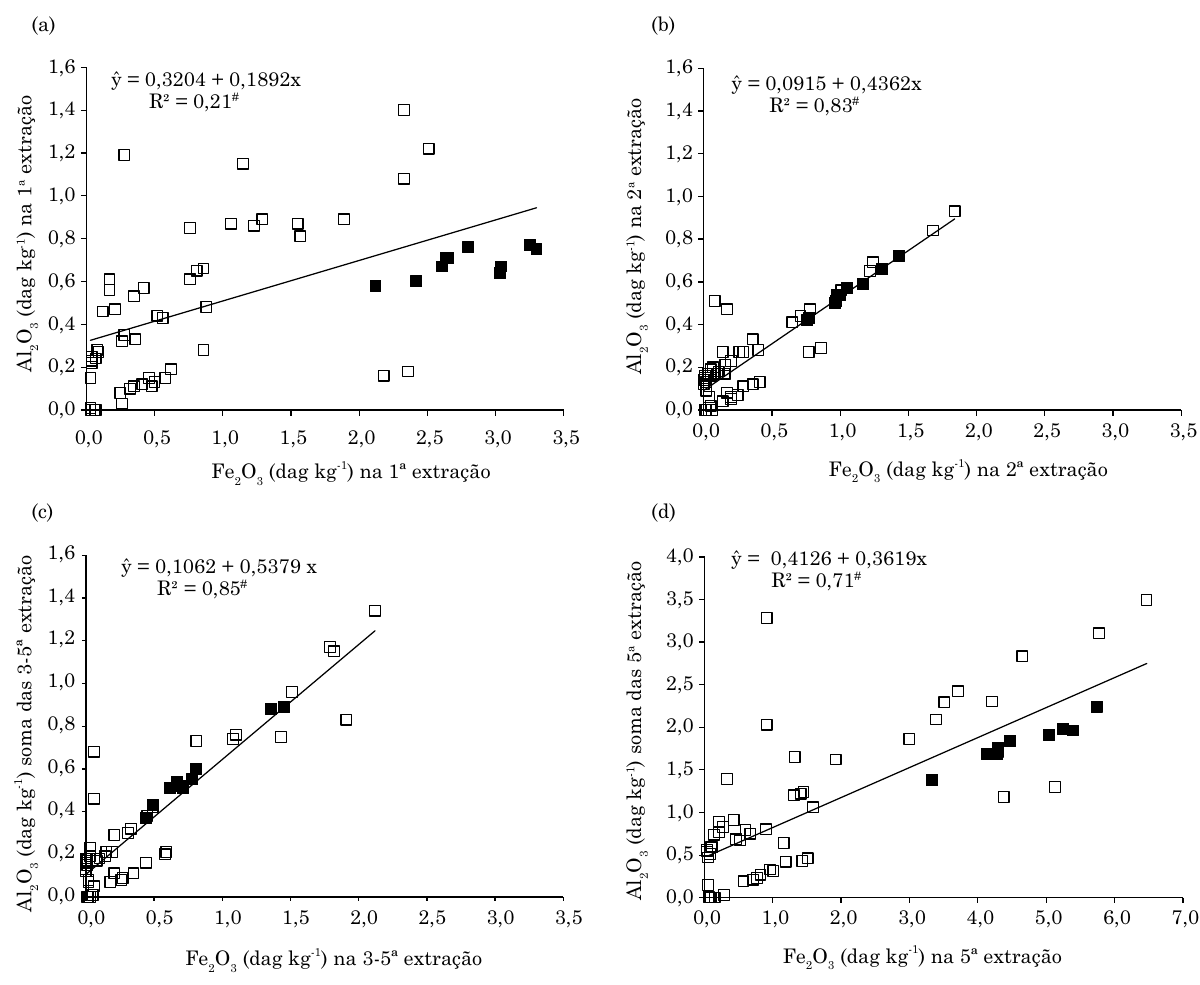
Figura 4. relação entre os teores de Fe 2 O 3 e al 2 O 3 extraídos por ditionito-citrato-bicarbonato (DCb) na terra fina seca ao ar: (a) para 1ª extração; (b) para 2ª extração; (c) para soma da 3ª, 4ª e 5ª extração; e (d) para soma de todas as extrações. # significativo a 0,1 %. Marcador sólido: solos vermelhos; e vazio: solos amarelos e